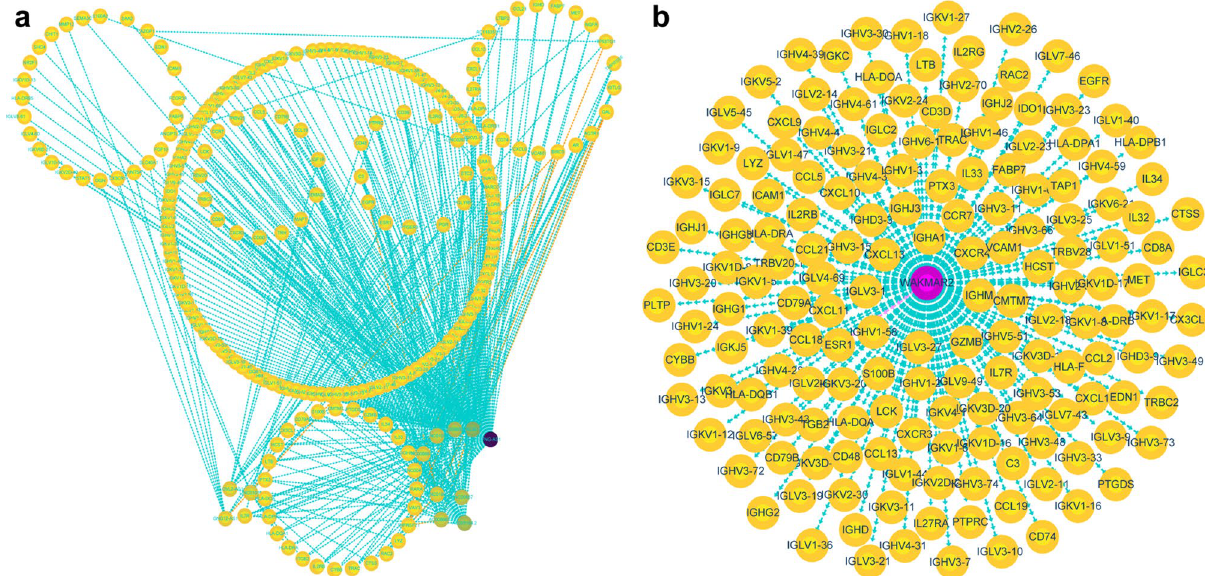
Figure 2. Interaction network between enhancer RNA (eRNA) and immune genes in invasive breast cancer. ( a ) Overall interaction network. Each circle represents an eRNA or a gene, and the darker the colour, the higher the node. The connection line represents the interaction between eRNA and immune genes, the blue line indicates a positive correlation, and the orange line indicates a negative correlation. ( b ) WAKMAR2 and its related target gene interaction network. Blue lines indicate a positive correlation, and pink-purple lines indicate a negative